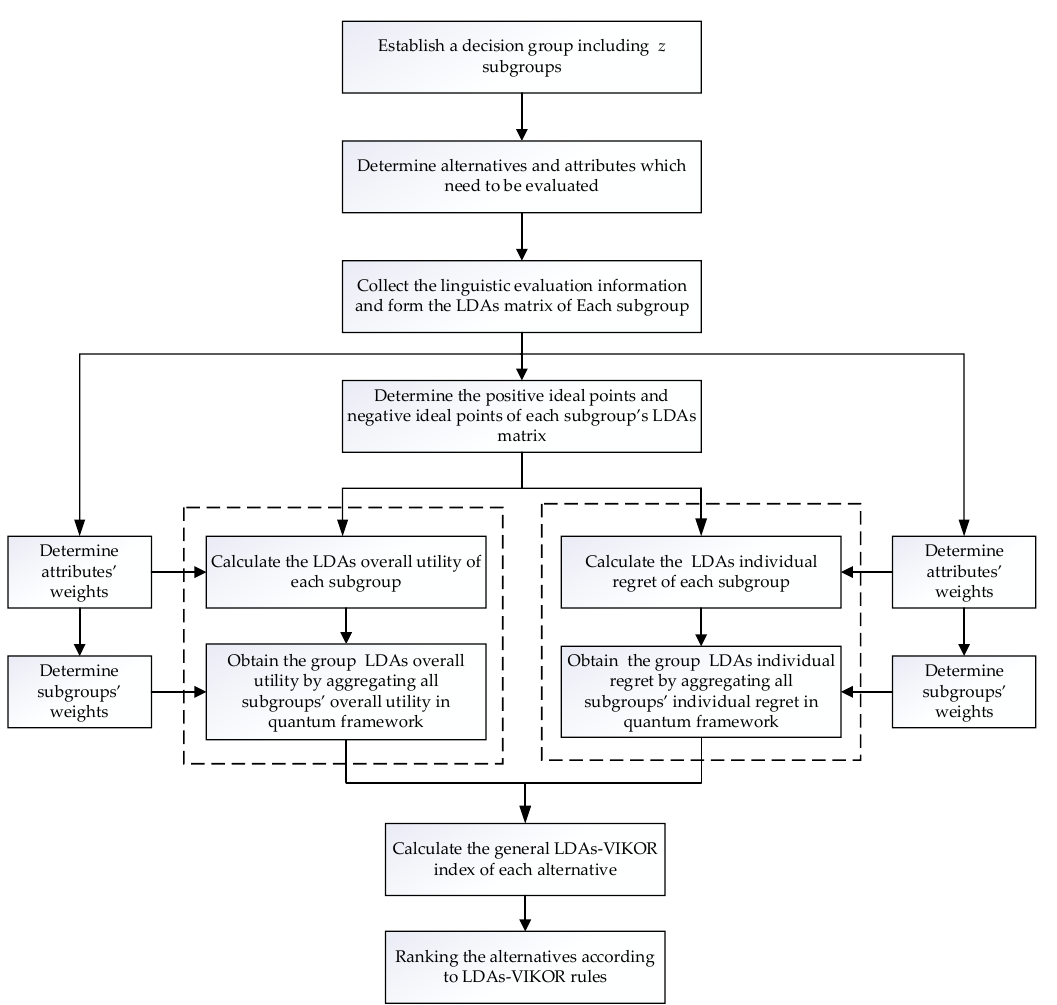
Figure 6. The process of quantum-based LDAs–VIKOR MAGDM model.